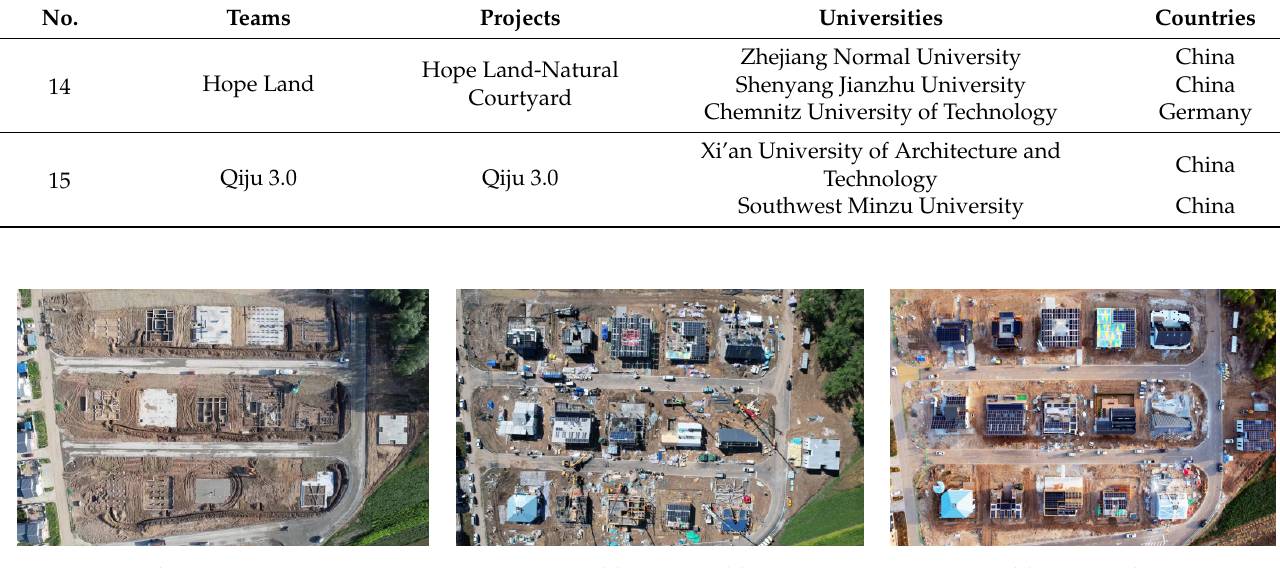
Figure 1. The Third SDC construction progress.